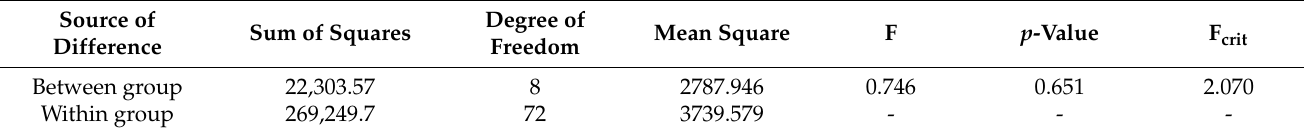
Table 6. The results of the ANOVA of the lateral tensile stress.